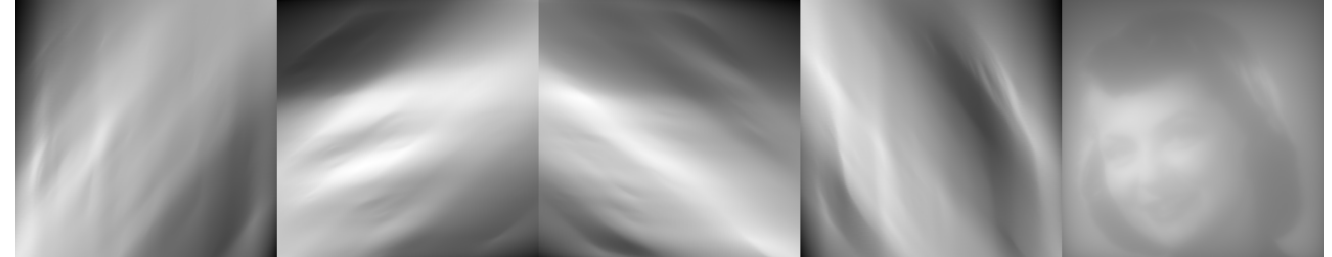
Figure 7. The adjoint discrete Radon transform, as defined by Equation (6), applied on each quadrant of the forward transform of the image, used as example through this paper. The image on the right corresponds to the adjoint of the whole DRT and is equivalent to the sum of the four images in the left. It is reminiscent of the unfiltered back-projection method used in medical imaging.